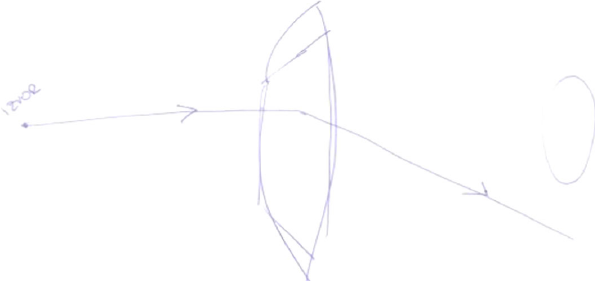
FIG. 7. The drawing of student S20_VG that shows the polarization of light on the sunglasses as the refraction of light. “ Izvor ” is the Croatian word for the source (of